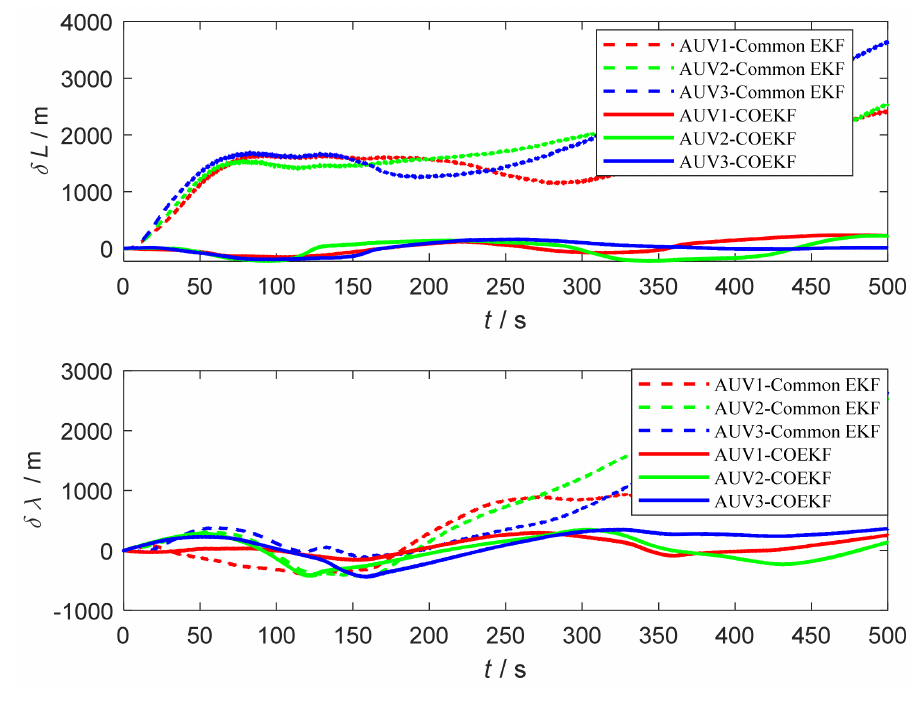
Figure 10. Position error comparison curve. The relative horizontal distance error curves for cooperative multi-boat navigation based on the combined-observation EKF are shown in Figure 11; the red, green, and blue dashed lines show the relative horizontal distance error curves between Boat 1 and Boat 2, between Boat 1 and Boat 3, and between Boat 2 and Boat 3, respectively, when autonomous navigation is based on pure SINS. The red, green, and blue solid lines show the relative horizontal distance error curves between the individual boats based on the combined-observation EKF for cooperative navigation.